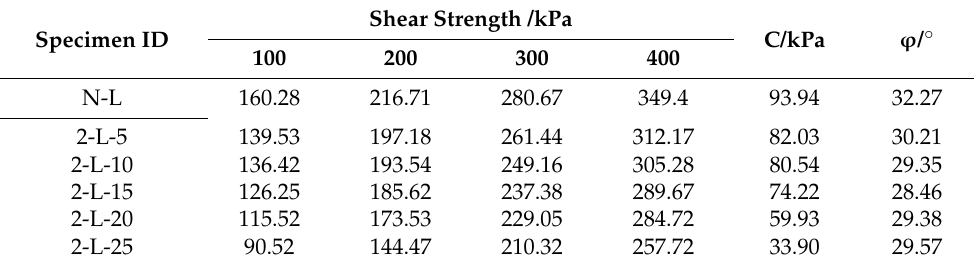
Table 3. The results of shear strength